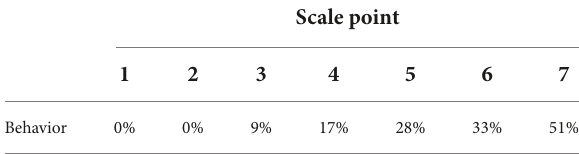
(reanalysis of data from Conner et al., 2021, Study